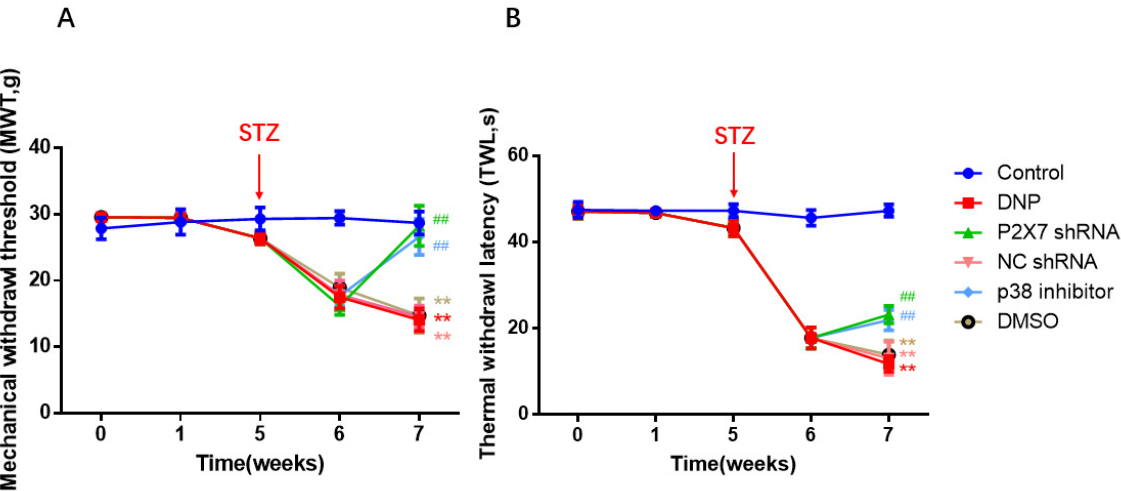
Figure 3. Results of MWT and TWL of all groups. ( A ) Changes in MWT values. ( B ) Changes in TWL values. At the end of the seventh week, MWT and TWL in the P2X7 shRNA and p38 inhibitor groups were higher than in the DNP group. The X-axis means the time of measuring behavior and drug administration, the detailed descriptions of 0, 1, 5, 6 and 7 are given in the Section 4; data are shown as mean ± SEM based on at least three independent experiments, n = 6; ** p < 0.01 versus the Control group; ## p < 0.01 versus the DNP group.